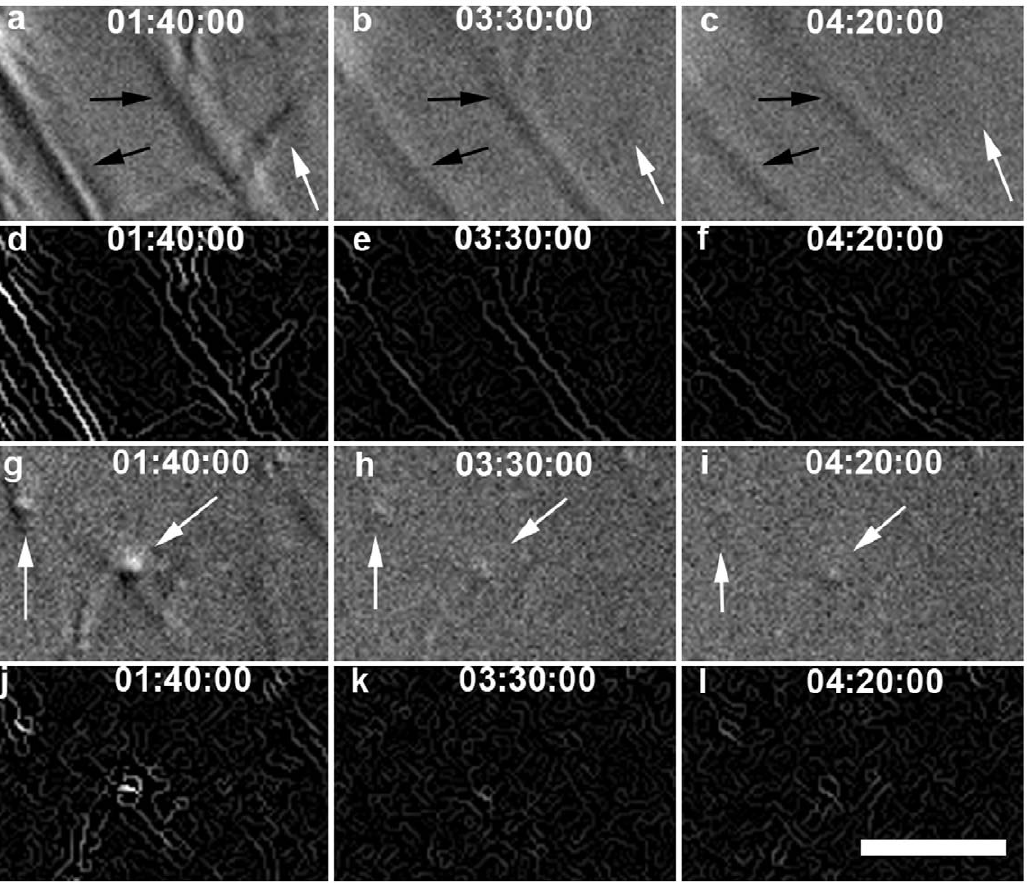
Figure 1. DIC and Edge detection results for loaded ROI # 8 (A–F) and unloaded ROI # 4 (G–L) from Fig. 5. (A–C, G–I) DIC image series of degradation, with intensity adjusted. (D–F, J–L) Edge detected intensity image series of degradation. In strained ROI # 8, the direction of strain, and the orientation of the predominant strained fibrils, is northwest-southeast (compare with Fig. 5). Black arrows denote strained fibrils, white arrows denote unstrained fibrils. Note how quickly the perpendicular, unstrained fibrils (seen as high contrast dots) fade compared to strained fibrils. Also note relatively unstrained fibrils in the strained ROI degrade much faster than strained fibrils. Bar =5 m m. (see SI movie for video of this sequence and accompanying text).